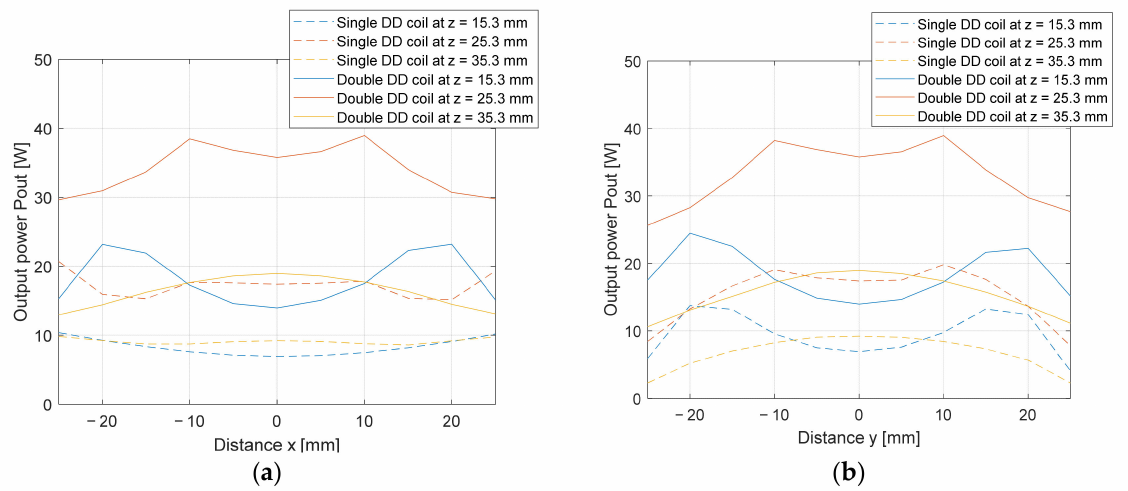
Figure 26. Impact of the horizontal x misalignment on the IPT power output: ( a ) misalignment in the direction of the x -axis; ( b ) misalignment in the direction of the y